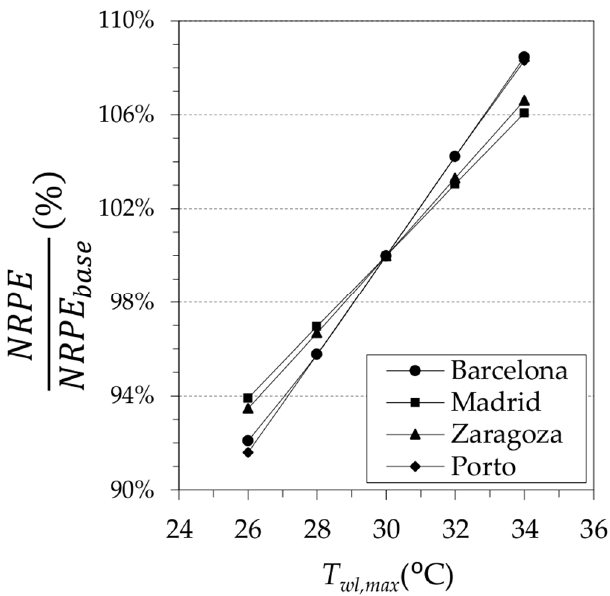
Figure 7. Effect of maximum water loop set point temperature in the annual nonrenewable primary energy consumption, with respect to the base case with 30 °C set point temperature, in the four cities.